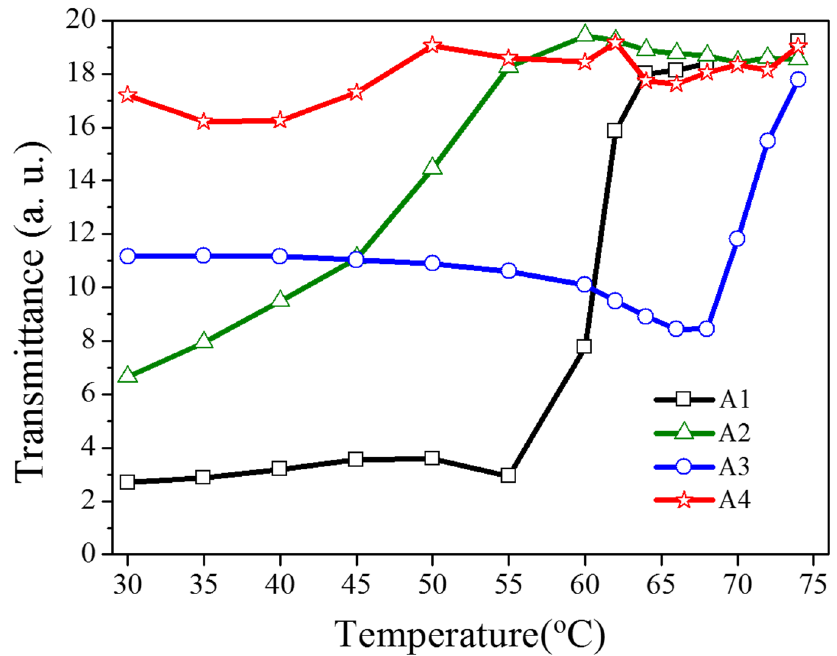
Figure 5. Transmittance of Azo-doped CLC samples dependent on the heating temperature. The order of CT-lowering ability is A4 > A2 > A1 > A3.